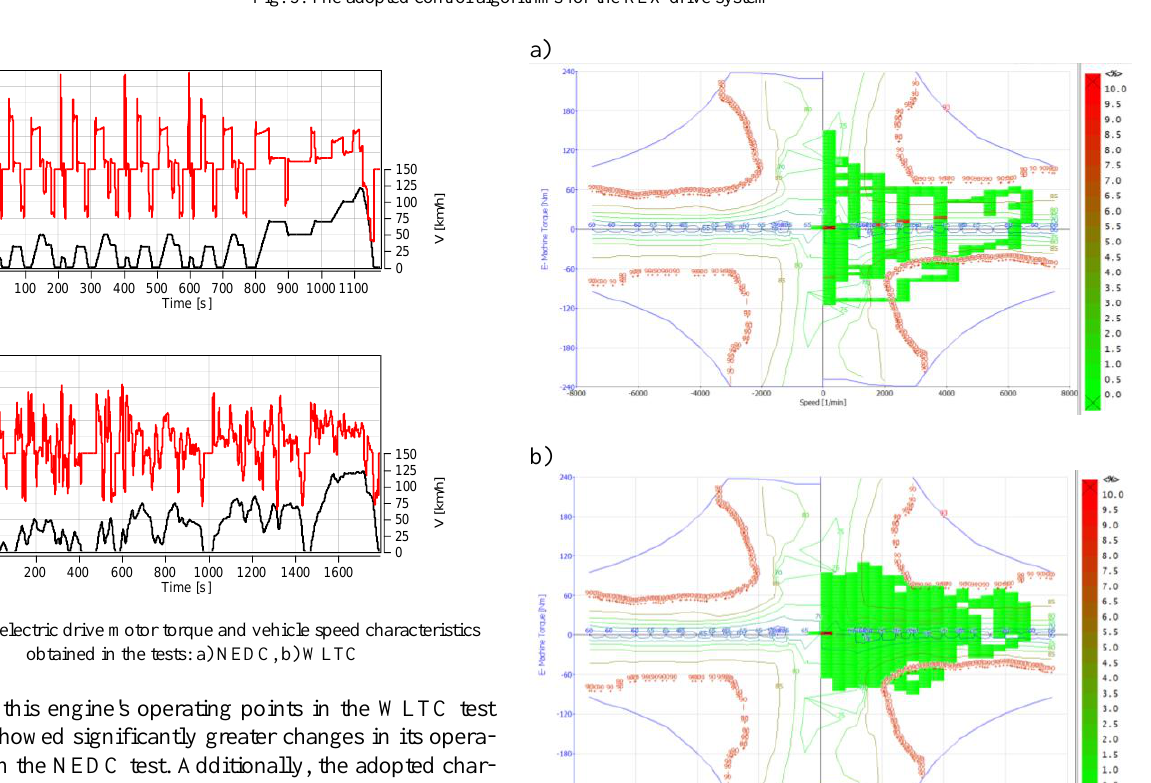
Fig. 5. The adopted control algorithms for the REX drive system